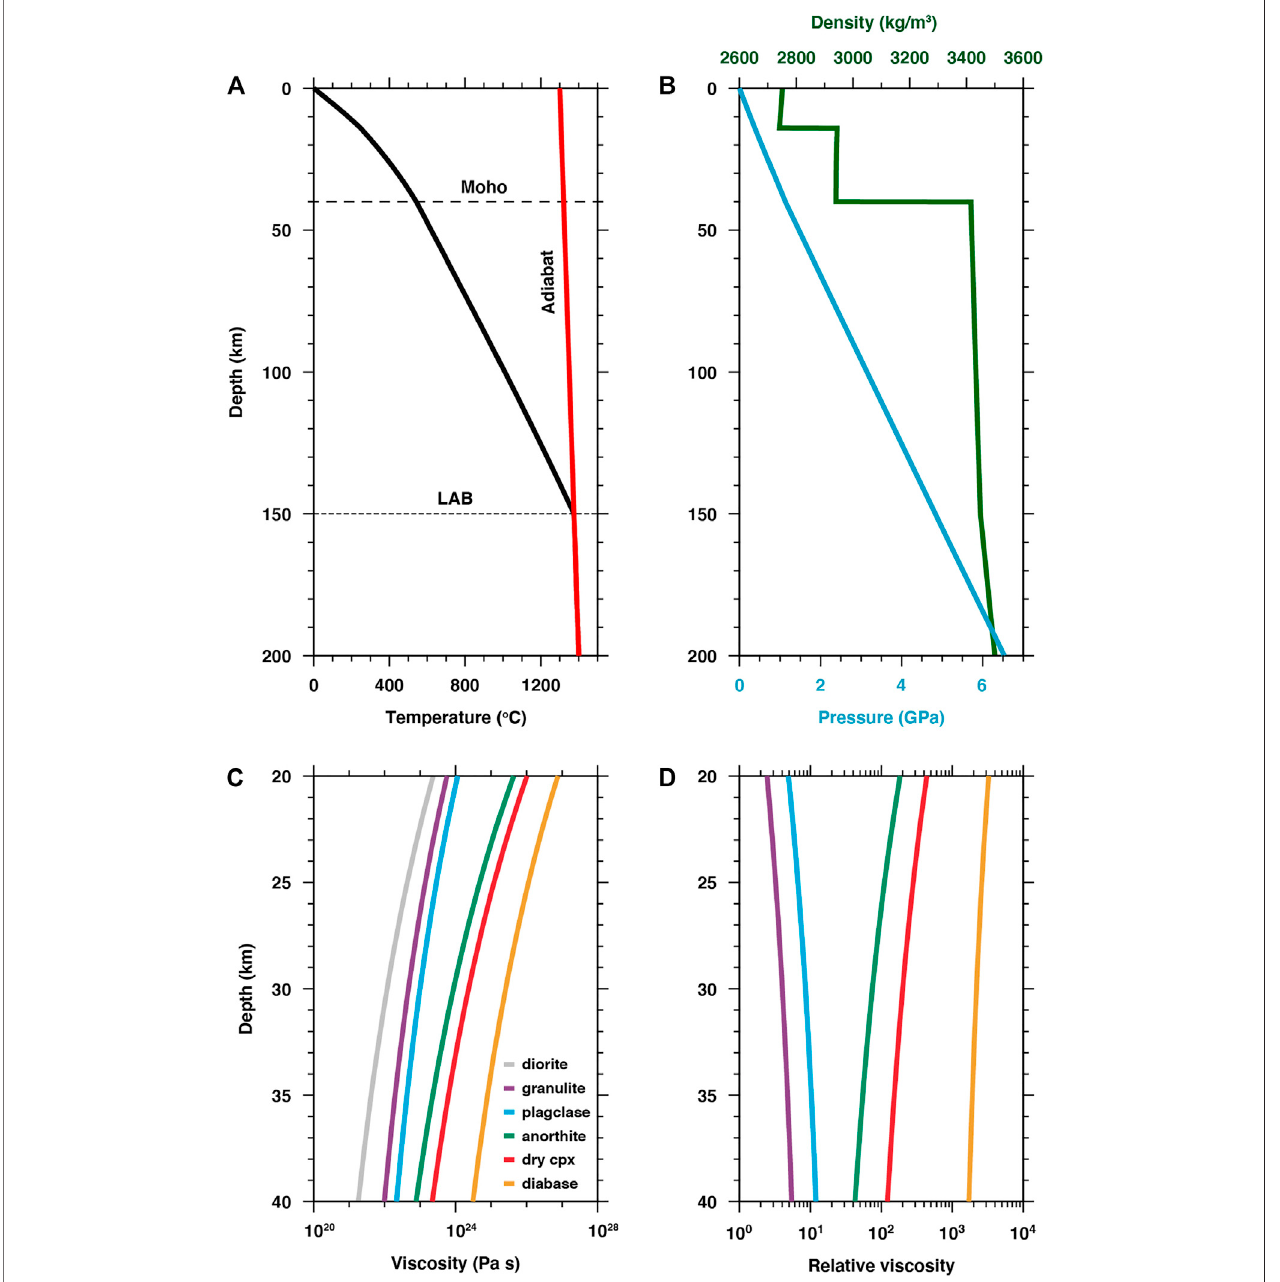
FIGURE1|(A) Initial geotherm used forcalculatingthelower crust viscosity.The continental lithosphereiscomposed ofa40-km-thick crust (a20-km-thickupper crust and a 20-km-thick lower crust) and a 110-km-thick mantle. The lithosphere-asthenosphere boundary (LAB) is determined by the intersection of the geotherm (black) with the mantle adiabat (red). (B) Density (dark green) and pressure (sky blue) pro fi les for the lithosphere based on the geotherm presented in (A) . (C) Effective viscosity of the lower crust as a function of depth for a variety of fl ow laws assuming a strain rate of 10 − 16 1/s. Diorite and plagioclase fl ow laws are from Ranalli (1995), granulite from Wang et al. (2012), anorthite from Rybacki and Dresen (2000), dry clinopyroxene (cpx) from Moghadam et al. (2010), and dry diabase from Mackwell et al. (1998). (D) Relative viscosity pro fi les compared to the diorite-derived viscosity in (C) .